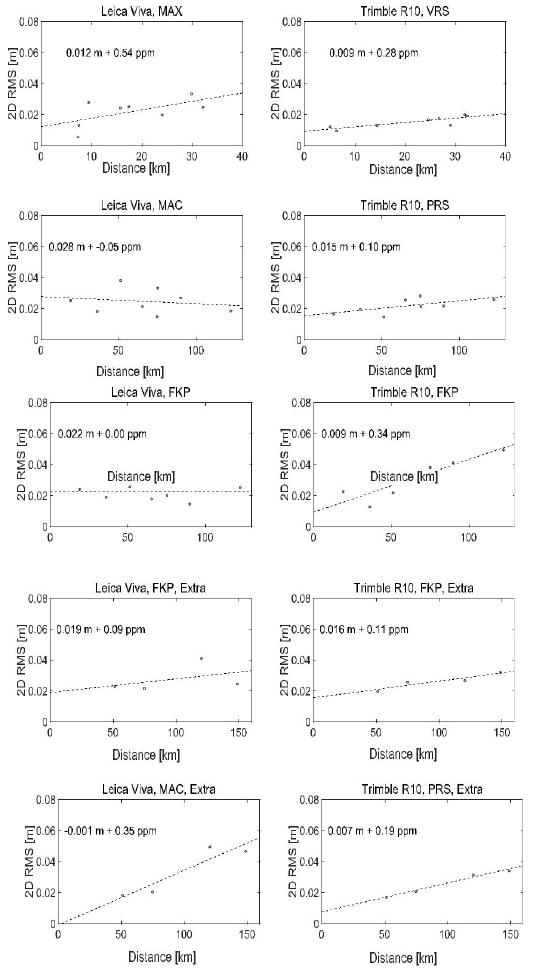
Figure 7: Horizontal rms at different test points. Float observations and failed initializations are excluded. The first row includes the results of commercial networks, and the following two rows refer to the NLS Positioning Service results in the interpolation measure- ments. The last two rows include the results of the extrapolation network measurements. Line is fitted to the plane RMS values. The equation of fitted lines are shown in the pictures.